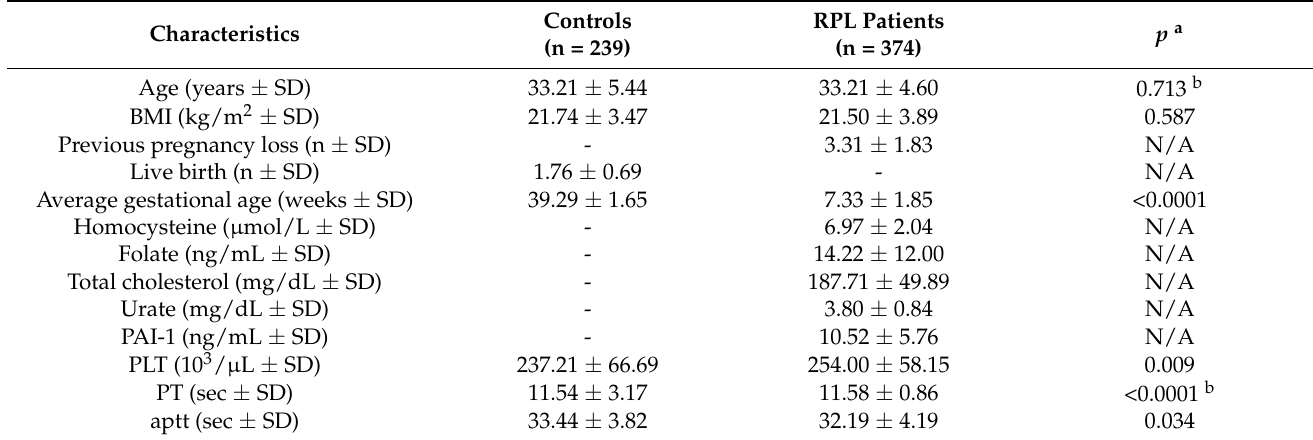
Table 1. The clinical profiles between the RPL patients and control